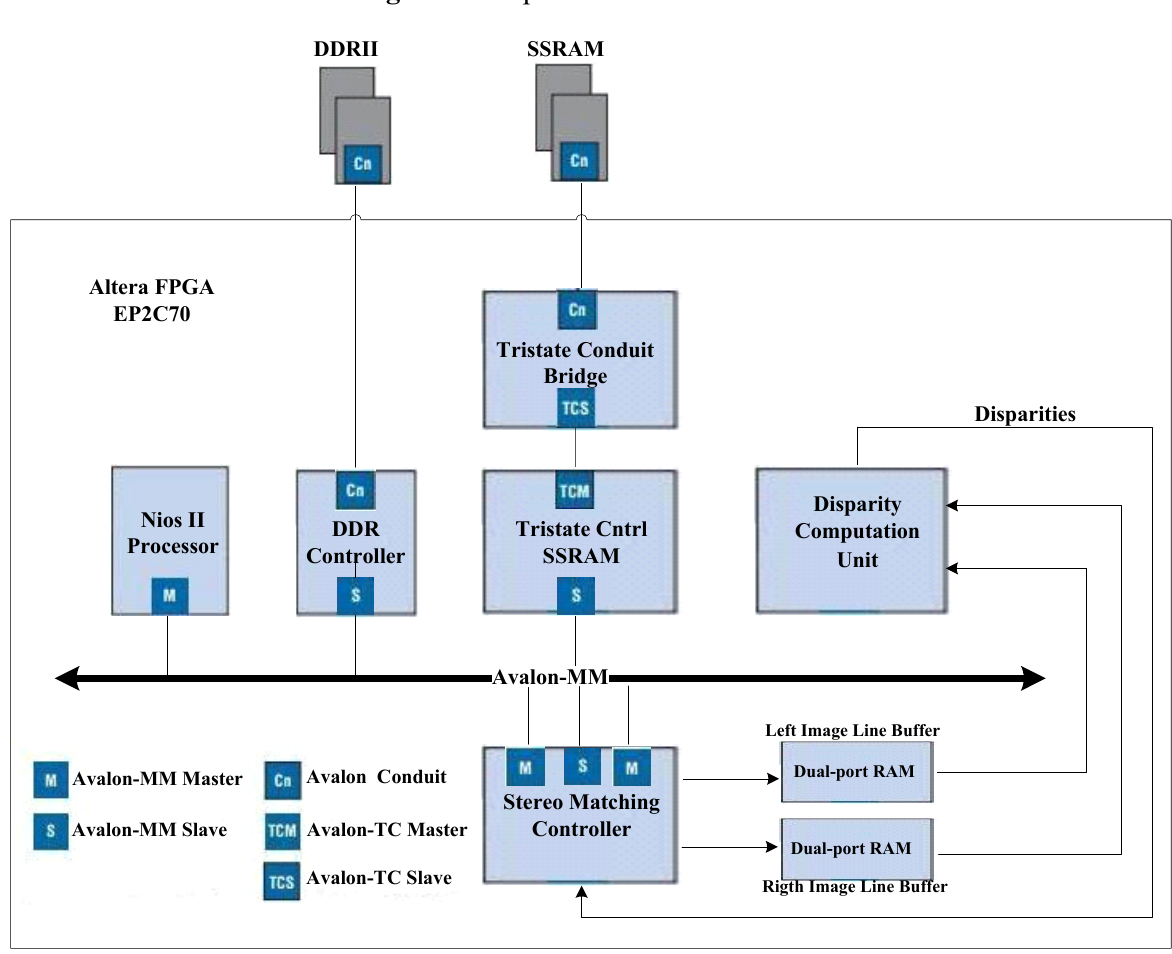
Figure 2. Proposed SoPC